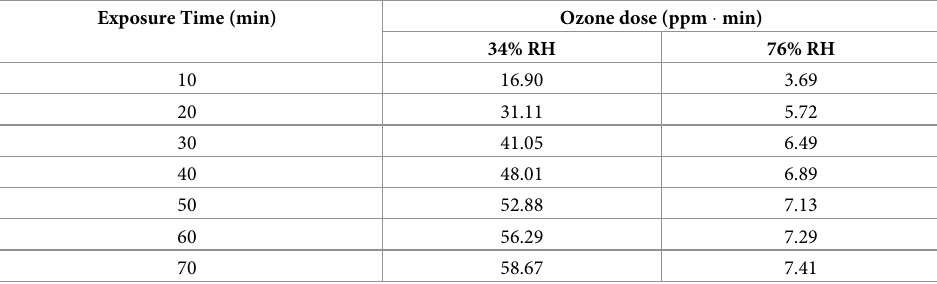
Table 1. Ozone doses floor value (ppm � min) for each exposure time at 34% and 76% RH.